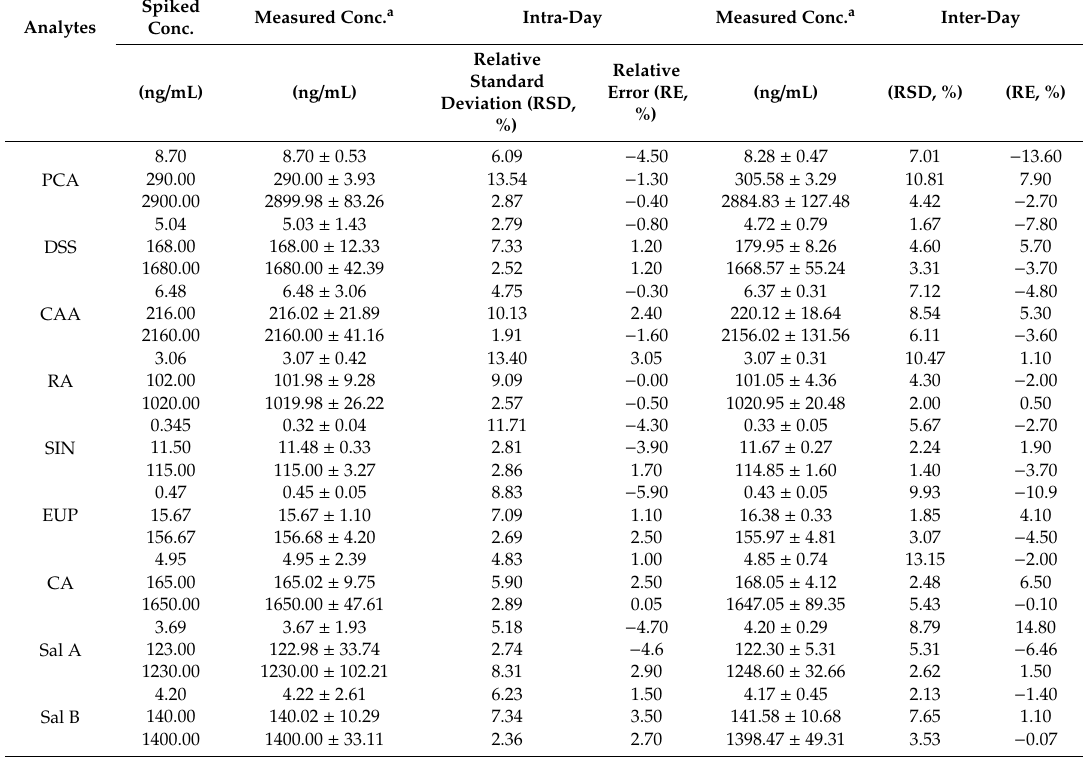
Table 2. Intra- and inter-day precision and accuracy of the nine analytes in rat plasma ( n = 6). Spiked Analytes